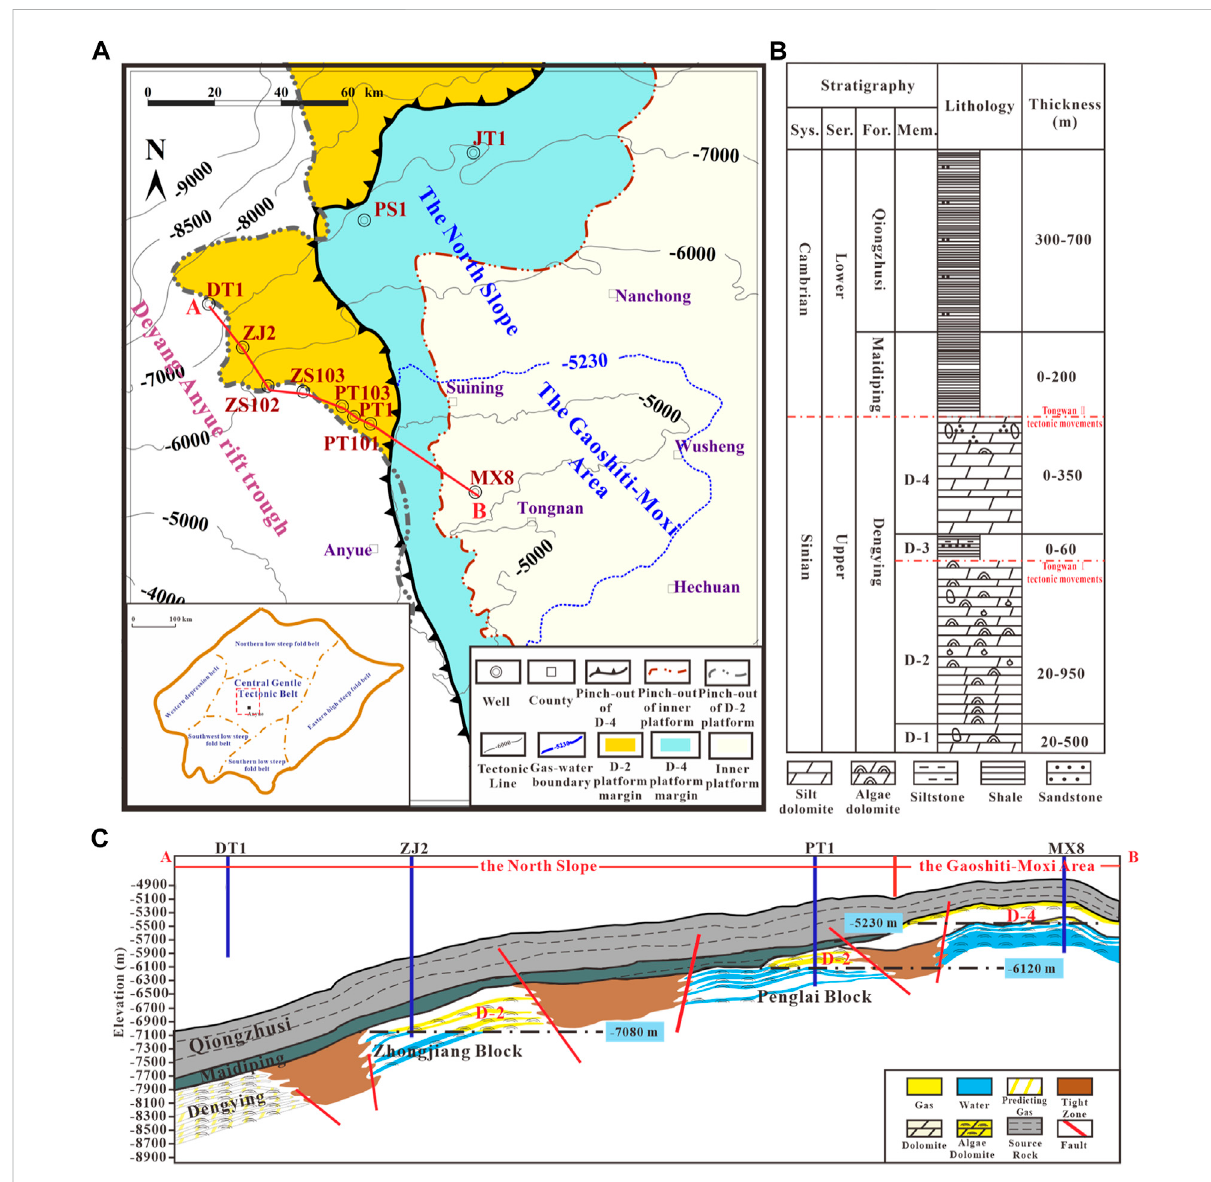
FIGURE 1 An overview of the geologic background of the research area. (A) The sedimentary facies of the Dengying Formation overlaying on the structuralmapoftheDengyingtopsurface. (B) StratigraphiccolumnoftheDengyingFormationanditssourcerocks. (C) Typicalgasreservoirpro fi les showing the gas-water relationships in the Gaoshiti-Moxi area (D-4), the North Slope (the Zhongjiang (D-2), and the Penglai Blocks